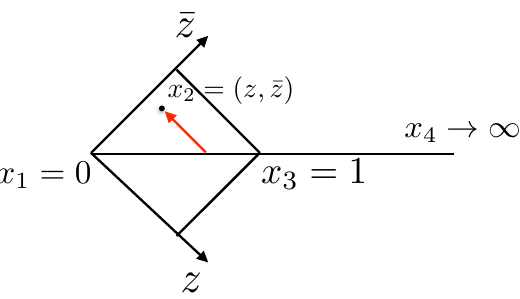
Figure 6 . The causal diamond where the Minkowski 4pt function is nonsingular. The 4pt function is real and positive in the diamond, symmetric with respect to the diagonal z = (cid:22) z . The function ( z; (cid:22) z ) decreases from the diagonal in the direction shown by the G